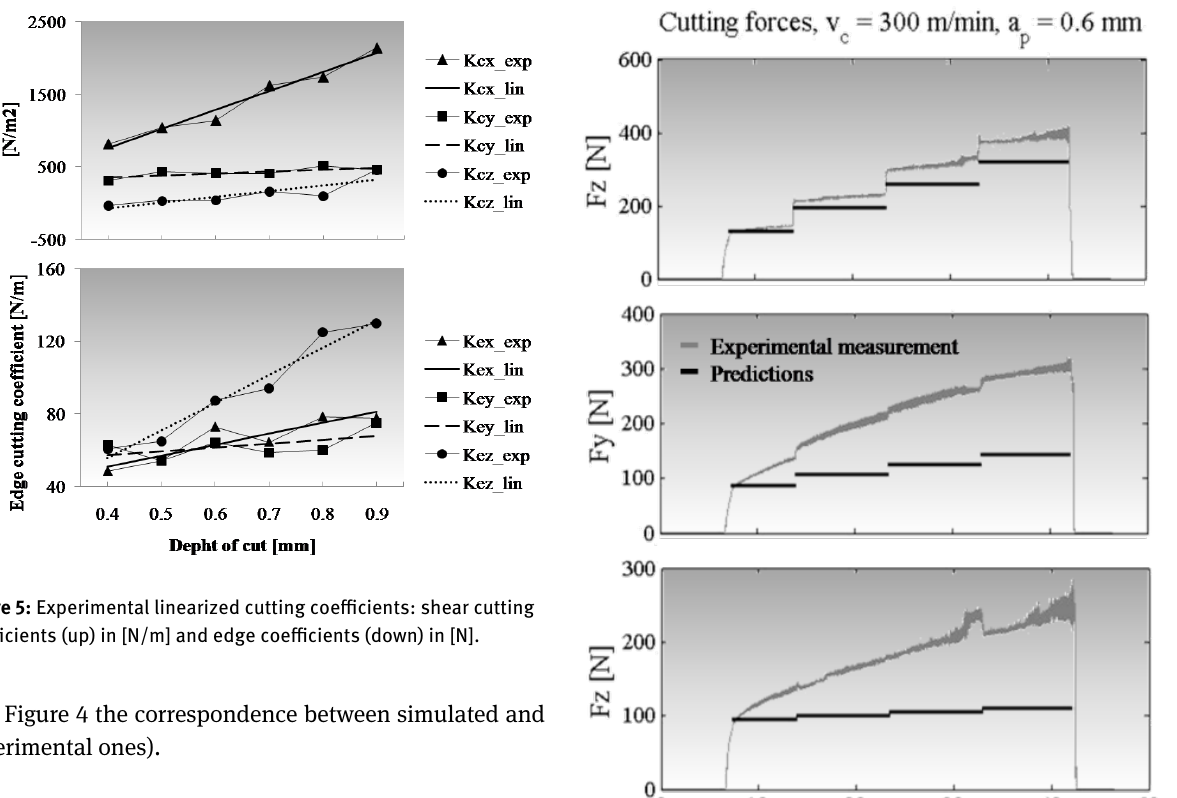
(see Figure 4 the correspondence between simulated and experimental ones).